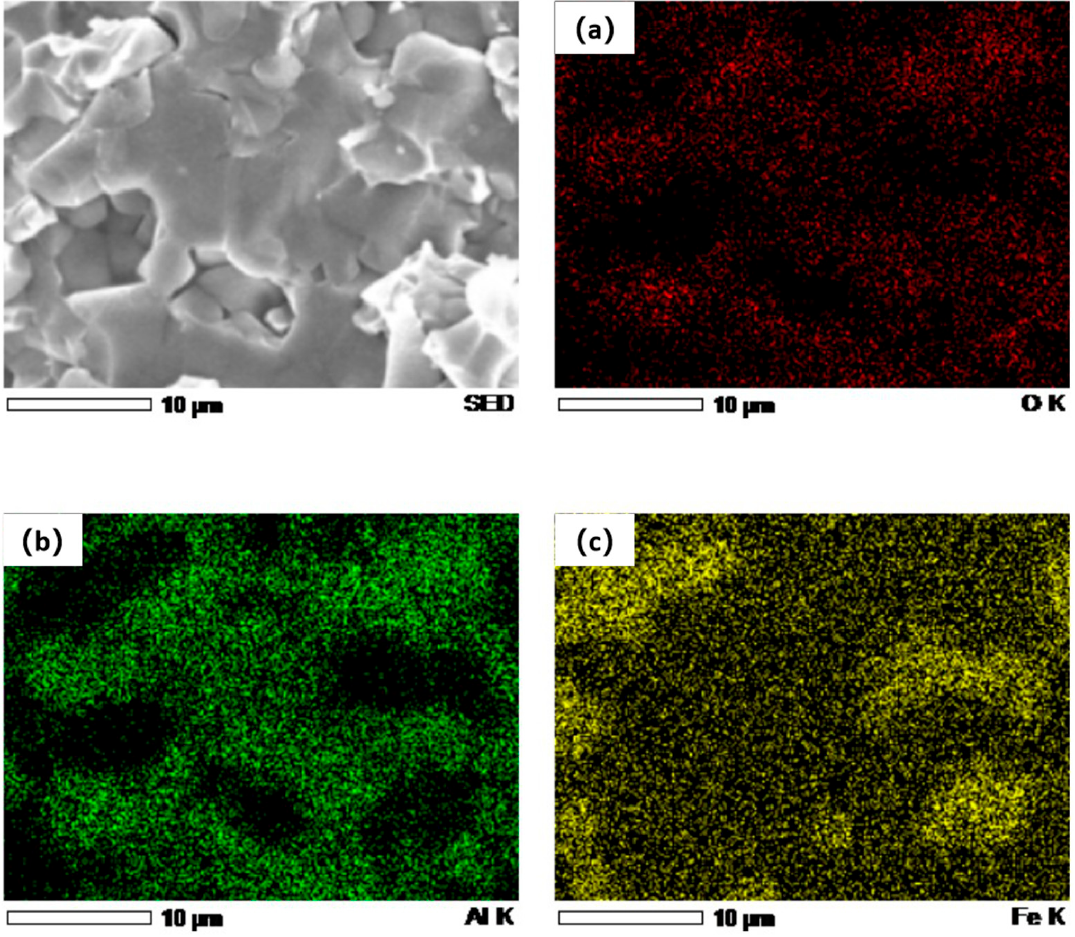
Figure 6. Mapping analysis for the major elements (Fe, Al, O) of Fe/FeAl 2 O 4 composites with Fe:Fe 2 O 3 :Al 2 O 3 at 6:1:2: ( a ) O; ( b ) Al; ( c ) Fe.